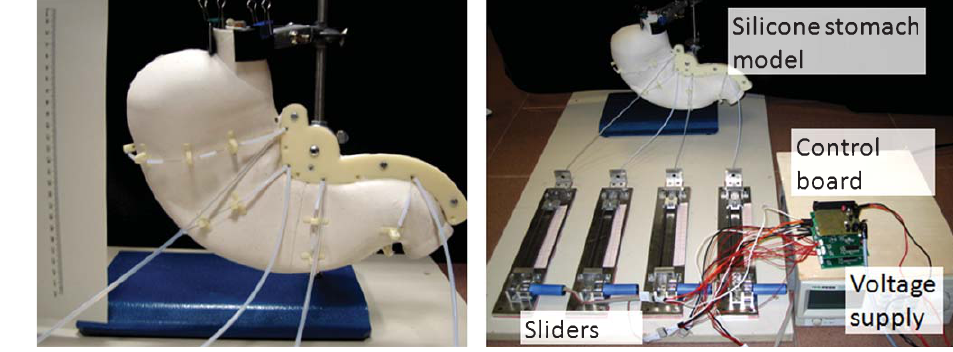
Fig. 7. Experimental setup of the stomach simulator.